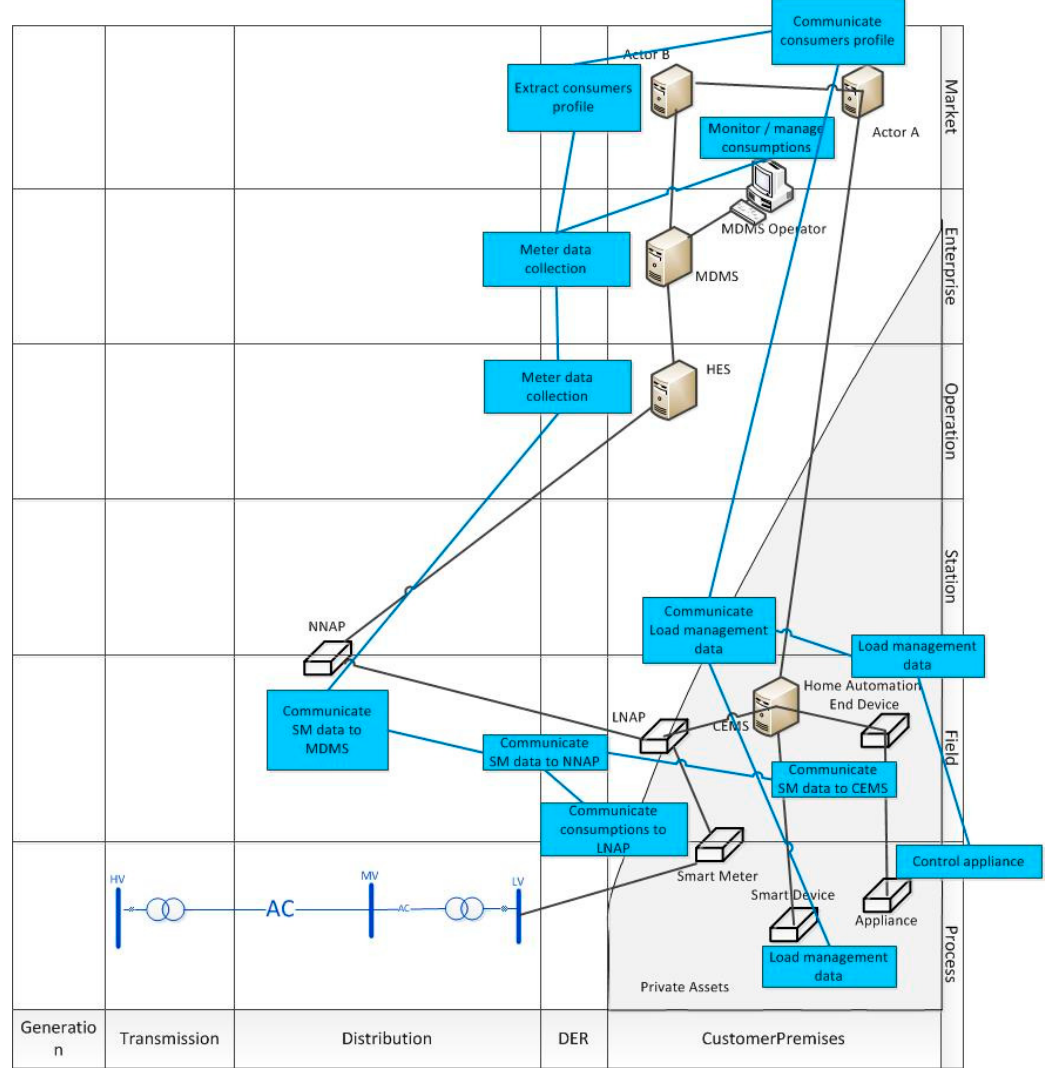
Figure 6. Function Layer.